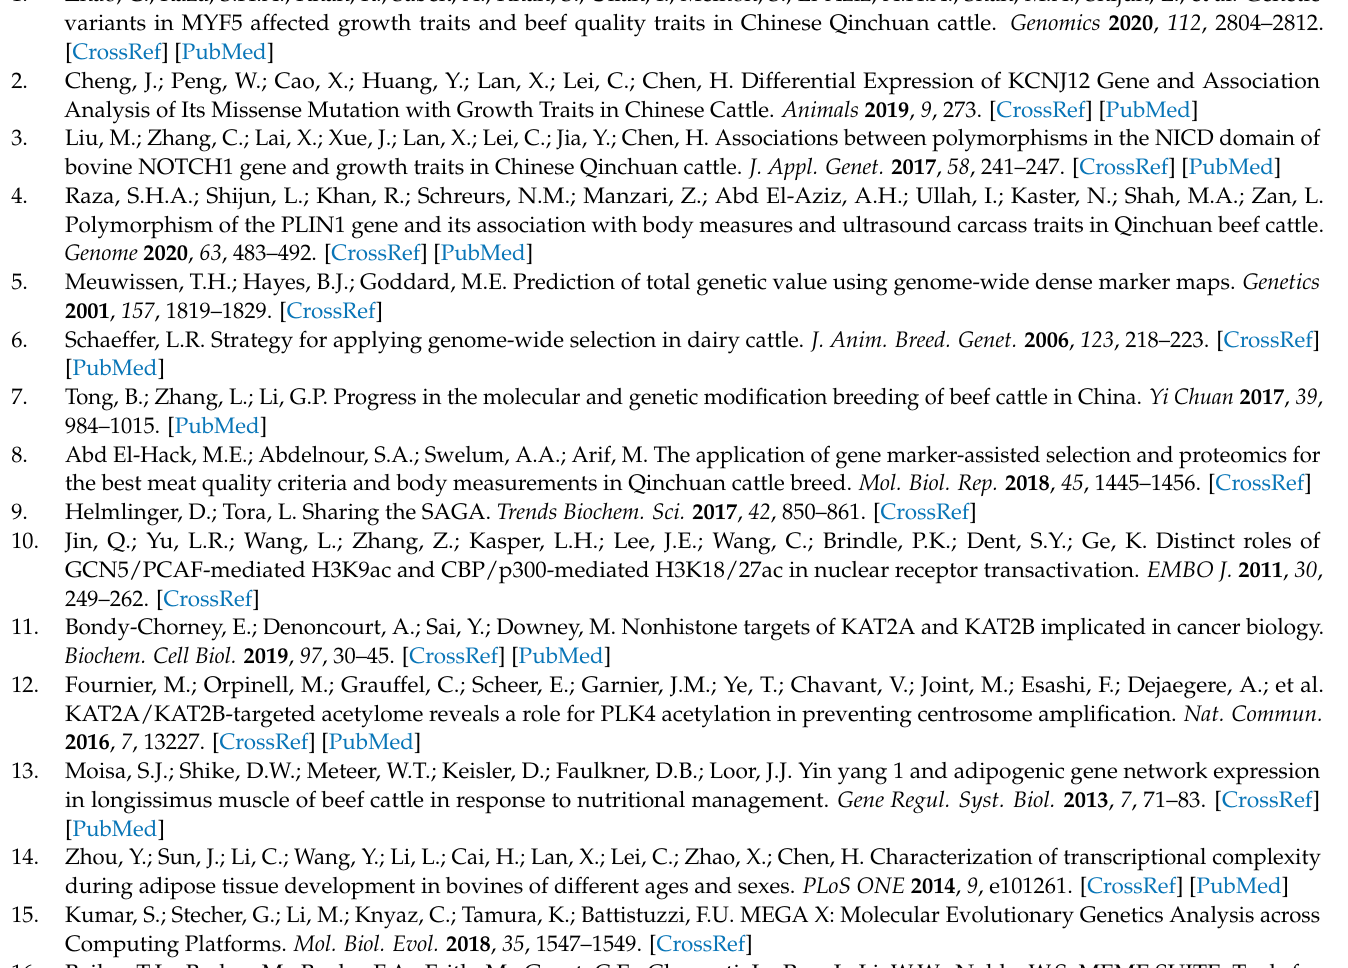
protein domain families in the 11 species; Table S1: Primers for exploring genetic variations of bovine KAT2B